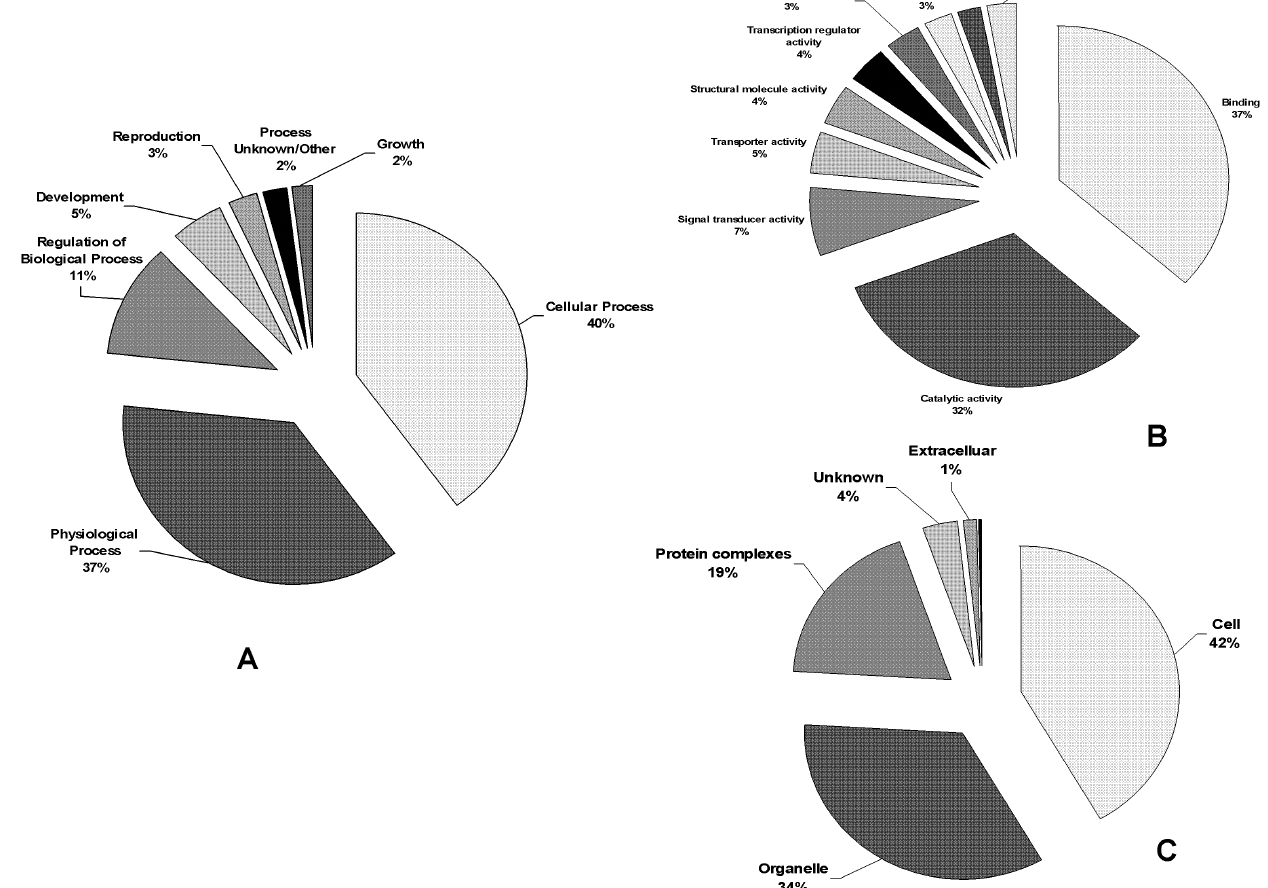
Figure 5. BLAST2GO categories of ESTs. ESTs were analyzed using the BLAST2GO software. Shown are level 2 categories for Biological Processes (A); Molecular Function (B); and Cellular Components